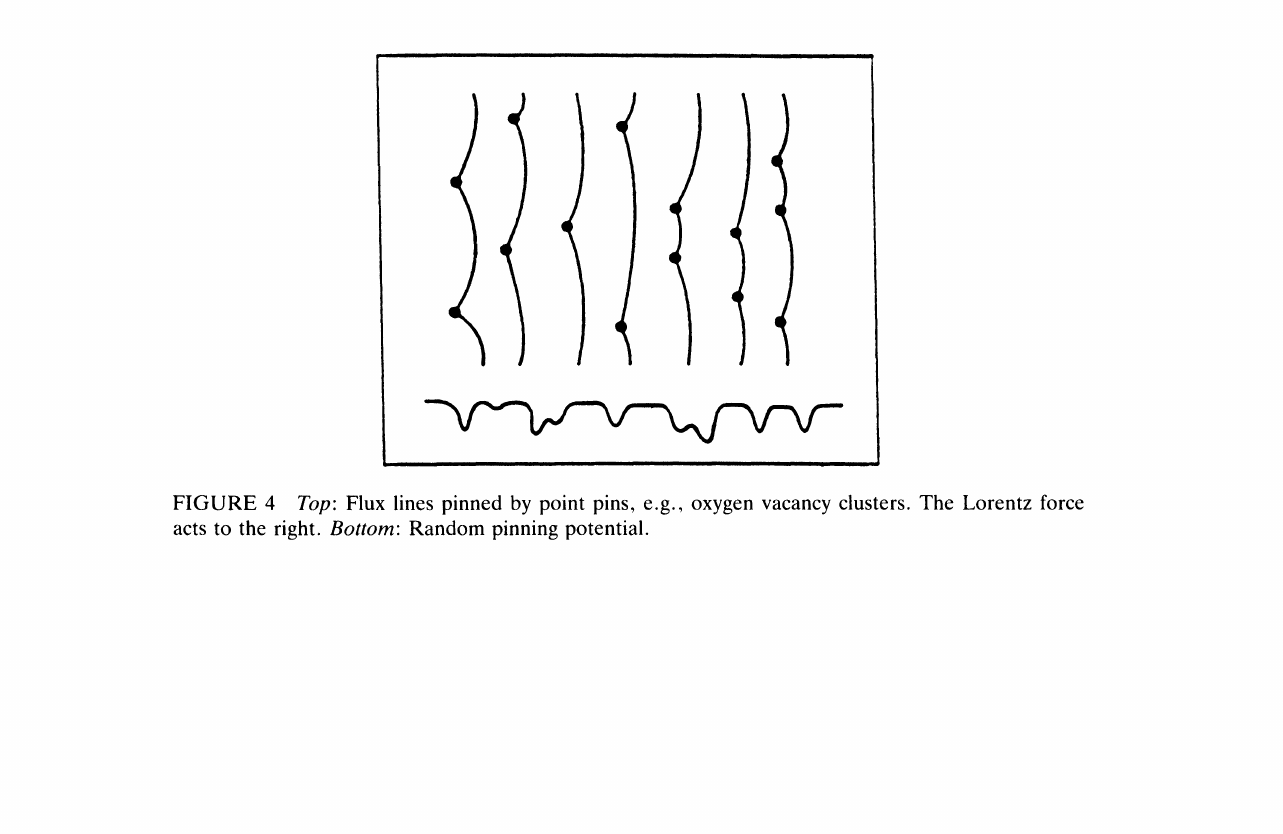
FIGURE 4 Top: Flux lines pinned by point pins, e.g., oxygen vacancy clusters. The Lorentz force acts to the right. Bottom: Random pinning